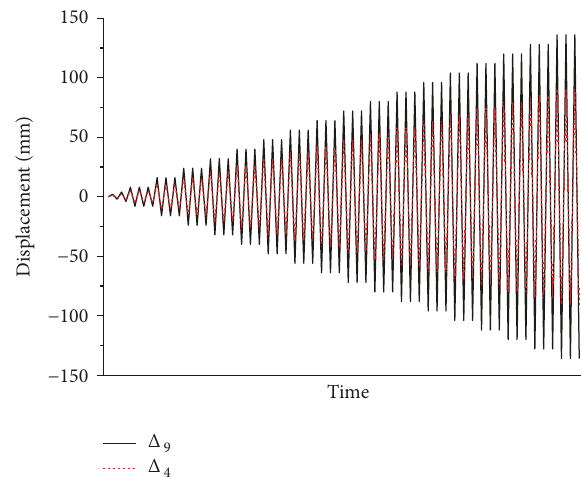
Figure 9: The history of loading program.